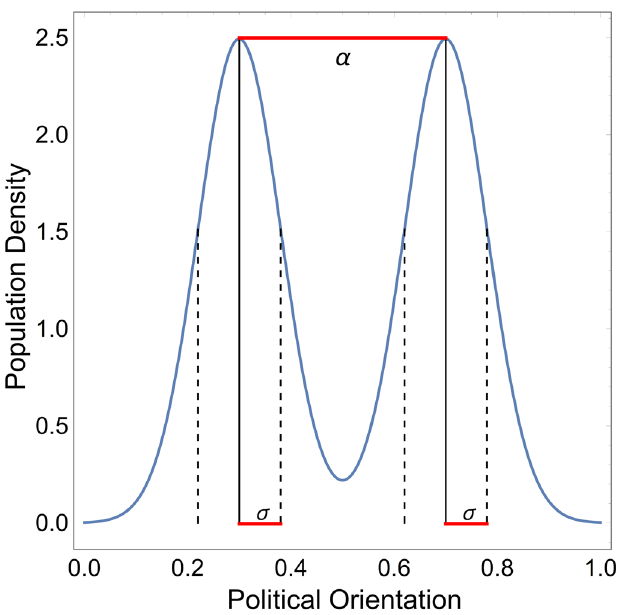
Fig. 1 Ideological distribution of voters as a function of the two population parameters, α and σ . α is the distance between the two subpopulation centers, and σ is the variance around these subpopulation centers. As σ increases, the population distributions will become less pronounced and more vote for the candidate who is closest to them ideologically. An additional concern is that extremist candidates, while energizing their own base, may increase turnout for people who are extre- mely opposed to their agenda as well (Hall and Thompson, 2018).